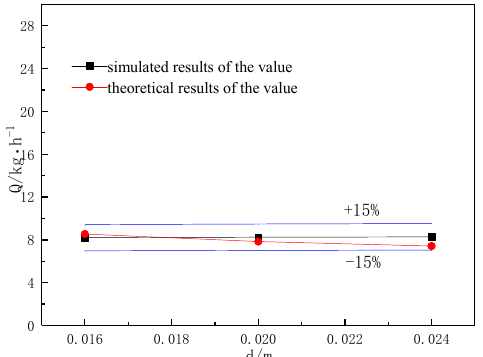
Figure 3. The comparison of simulation results and formula calculation results of the value of the feed at different drainage tube diameters.